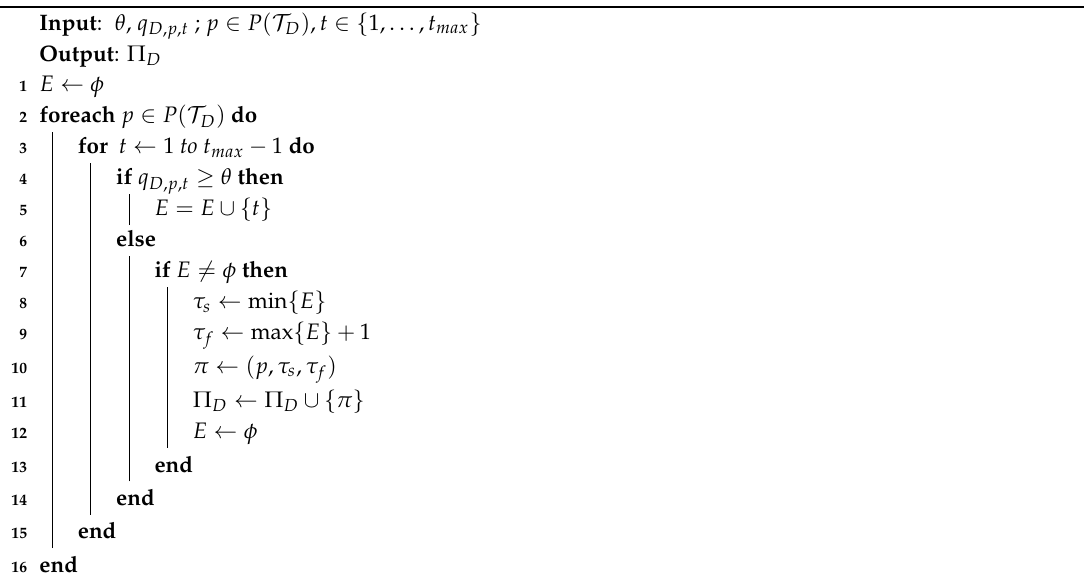
Algorithm 2: Algorithm for STP Pattern